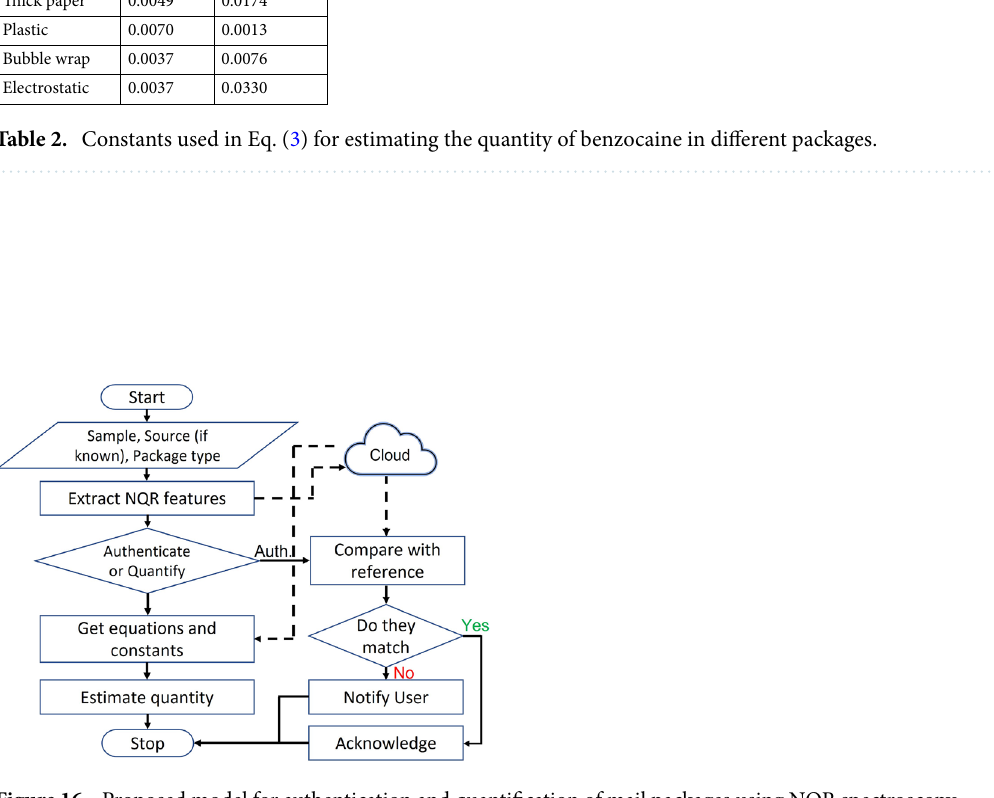
Figure 16. Proposed model for authentication and quantification of mail packages using NQR